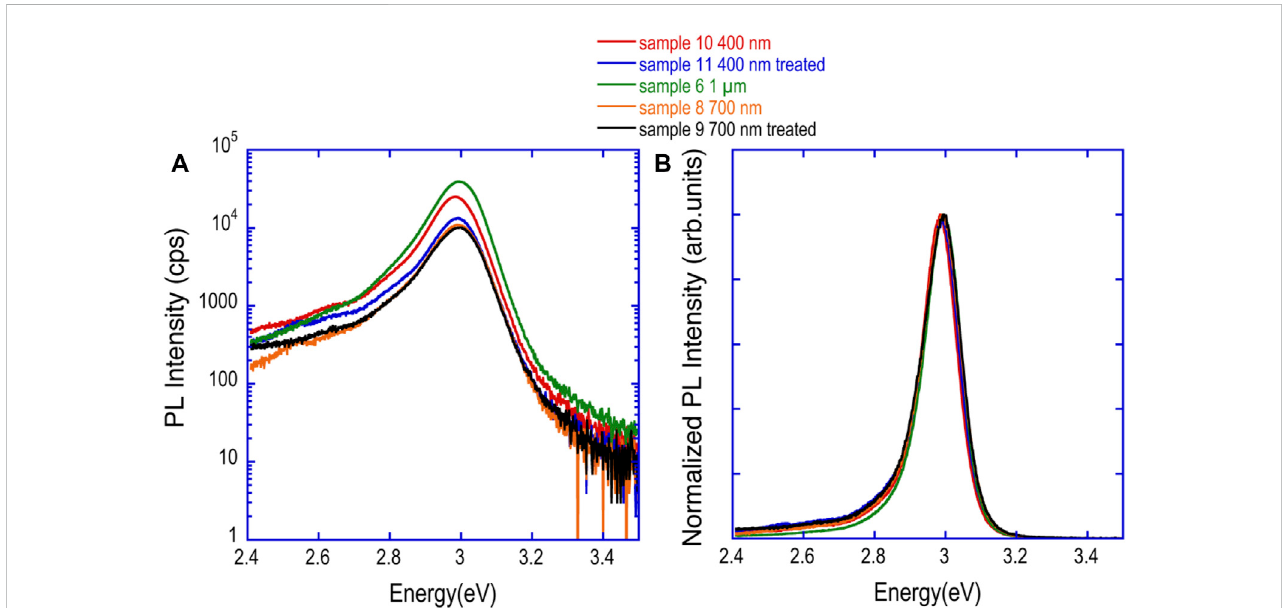
FIGURE 3 Photoluminescence spectra (PL) spectra for the different samples: in (A) the intensity is shown in log scale, in (B) normalized spectra are reported for a comparison of the lineshape.